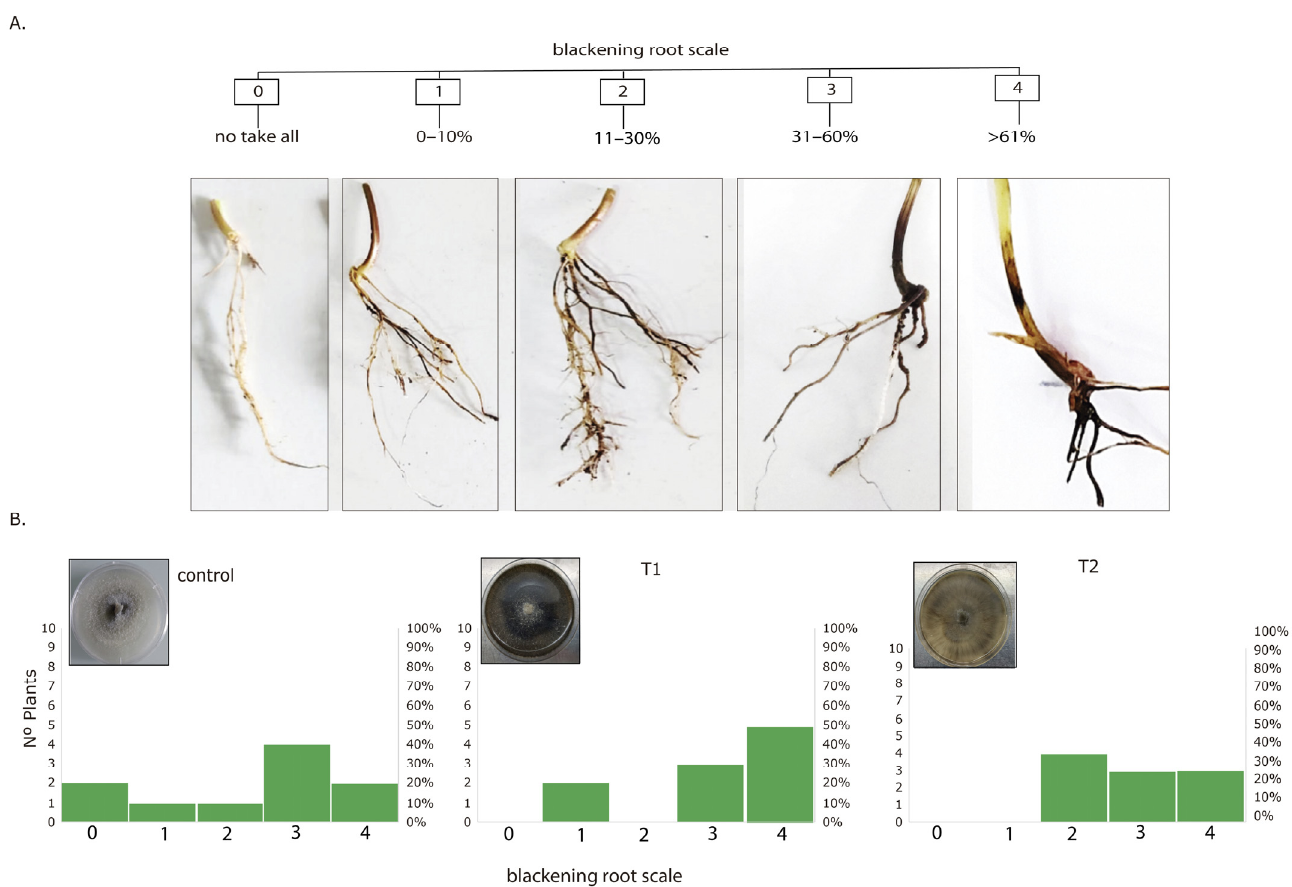
Figure 3. ( A ) Infection scale. 0: no take-all; 1: 1% to 10%; 2: 11% to 30%; 3: 31% to 60%; and 4: 61% to 100% of blackening roots, ( B ) Nº plants infected with take-all (blackening roots) according to infection scale after 60 days.